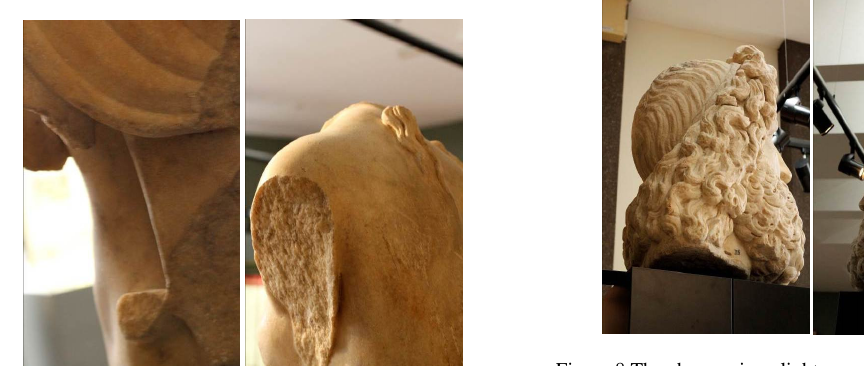
Figure 8 The changes in enlightenment between two images of the same objects acquired from different points of